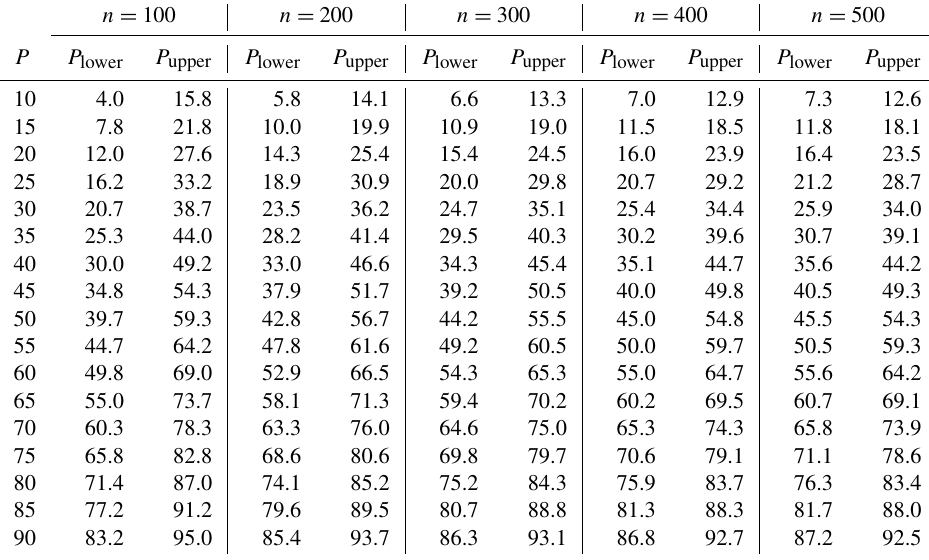
Table B1. Upper and lower percentile confidence interval bounds for α = 0 . 05 (95% confidence level).